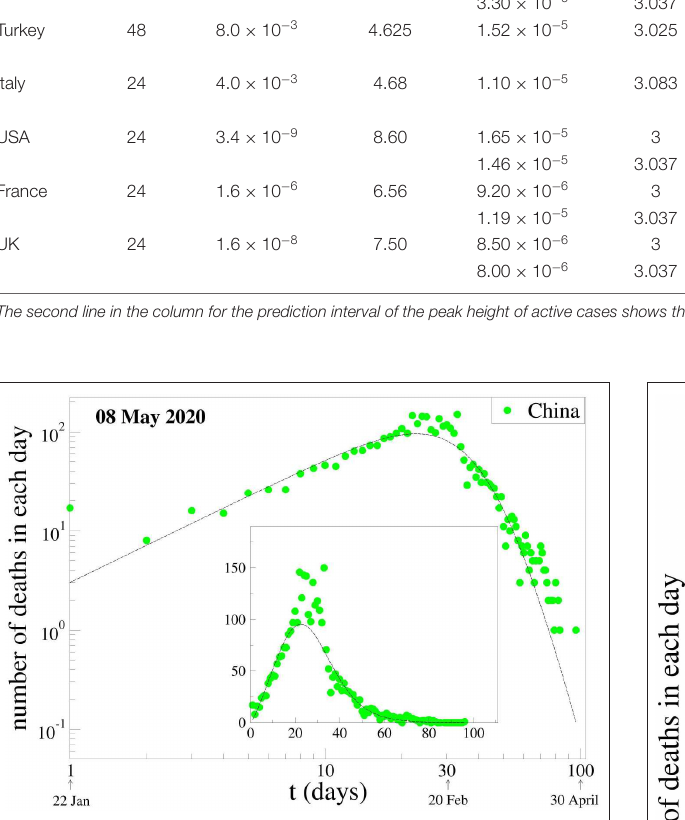
FIGURE 3 | Evolution of deaths due to COVID-19 per day in China. The data are those available at 28 April 2020. The fitting parameters γ and q are fixed at one of the two choices for the values for China, namely ( γ , q ) = (3,1.26). The other fitting parameters, namely ( C death , α death , β death ), have been chosen to better fit the data available for China.